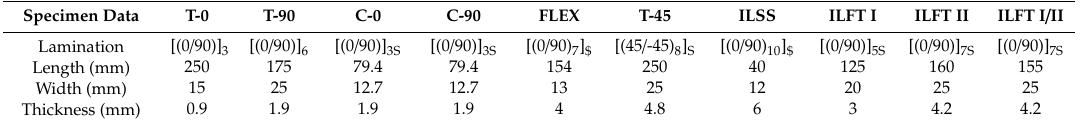
Table 1. Specimens dimensions and lamination ($ denotes odd number of plies, as: FLEX—13 plies, ILSS—19 plies).